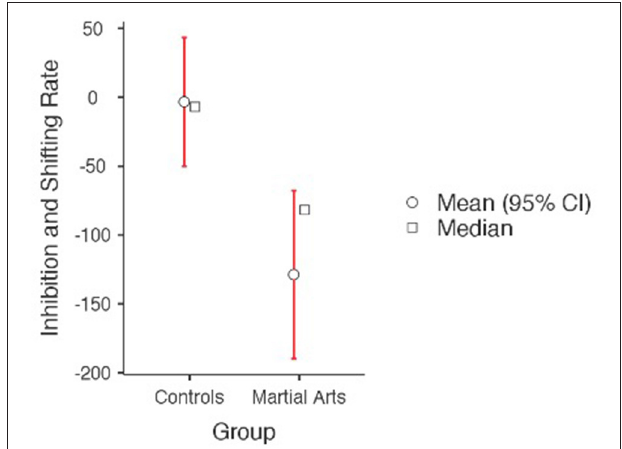
FIGURE 1 | Performance on CANTAB multitasking of inhibition and shifting rate (higher scores reflect poorer performance). A significant group difference was found, p = 0.003.